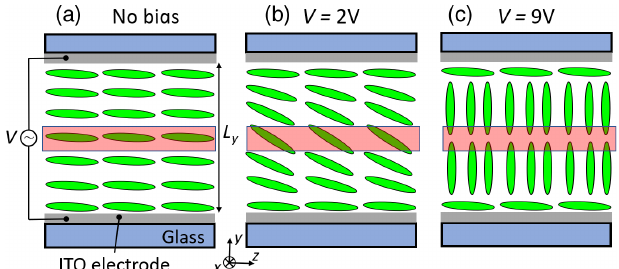
FIG. 9. Effects of the bias on molecular orientation. Qualitative distribution of the optical director when (a) no bias is applied and when a sinusoidal voltage of amplitude (b) 2 V and (c) 9 V is applied. In panel (b), the dynamic contribution to the phase delay is dominant over the geometric one (see the experiments shown in Fig. 8). In panel (c), the geometric phase is instead dominant, and the dynamic part is negligibly small (see all the other experiments shown in the paper). The red transparent rectangle shows the zone where the optical beam is propagating. The input interface is not shown, for simplicity, and the plot is not to